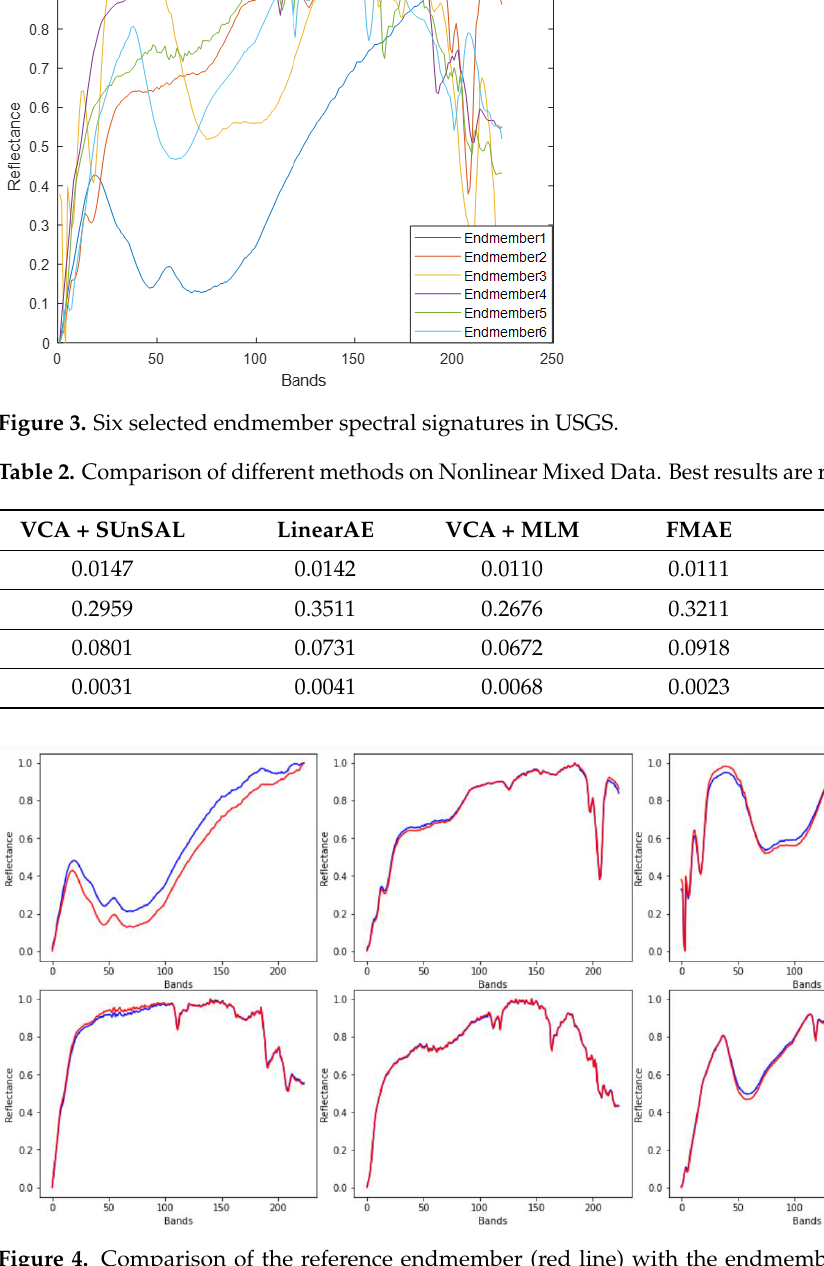
Figure 4. Comparison of the reference endmember (red line) with the endmember extracted by GBM_AE (blue line) on Nonlinear Mixed Data.